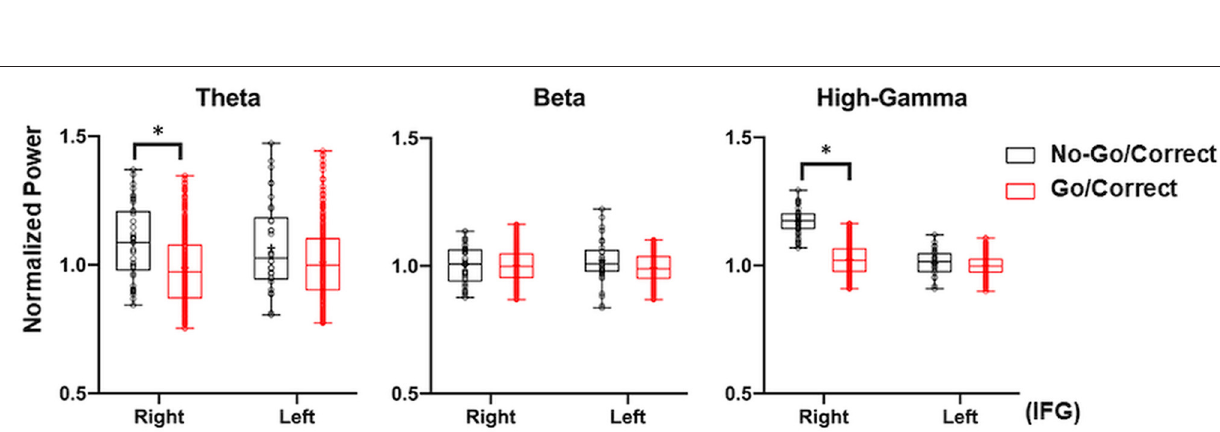
Frontiers in Neurology |